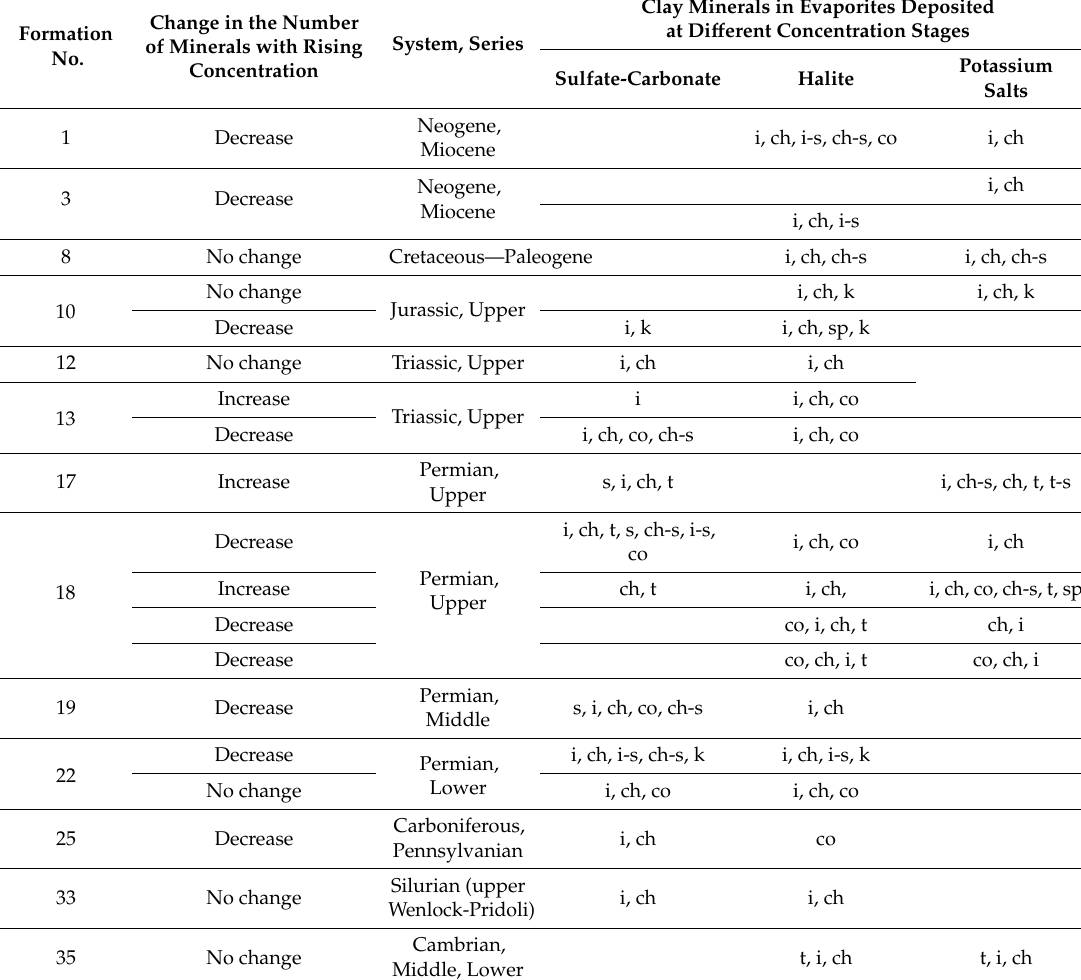
Table 3. Changes in clay minerals at di ff erent stages of brine concentration. Formation number as